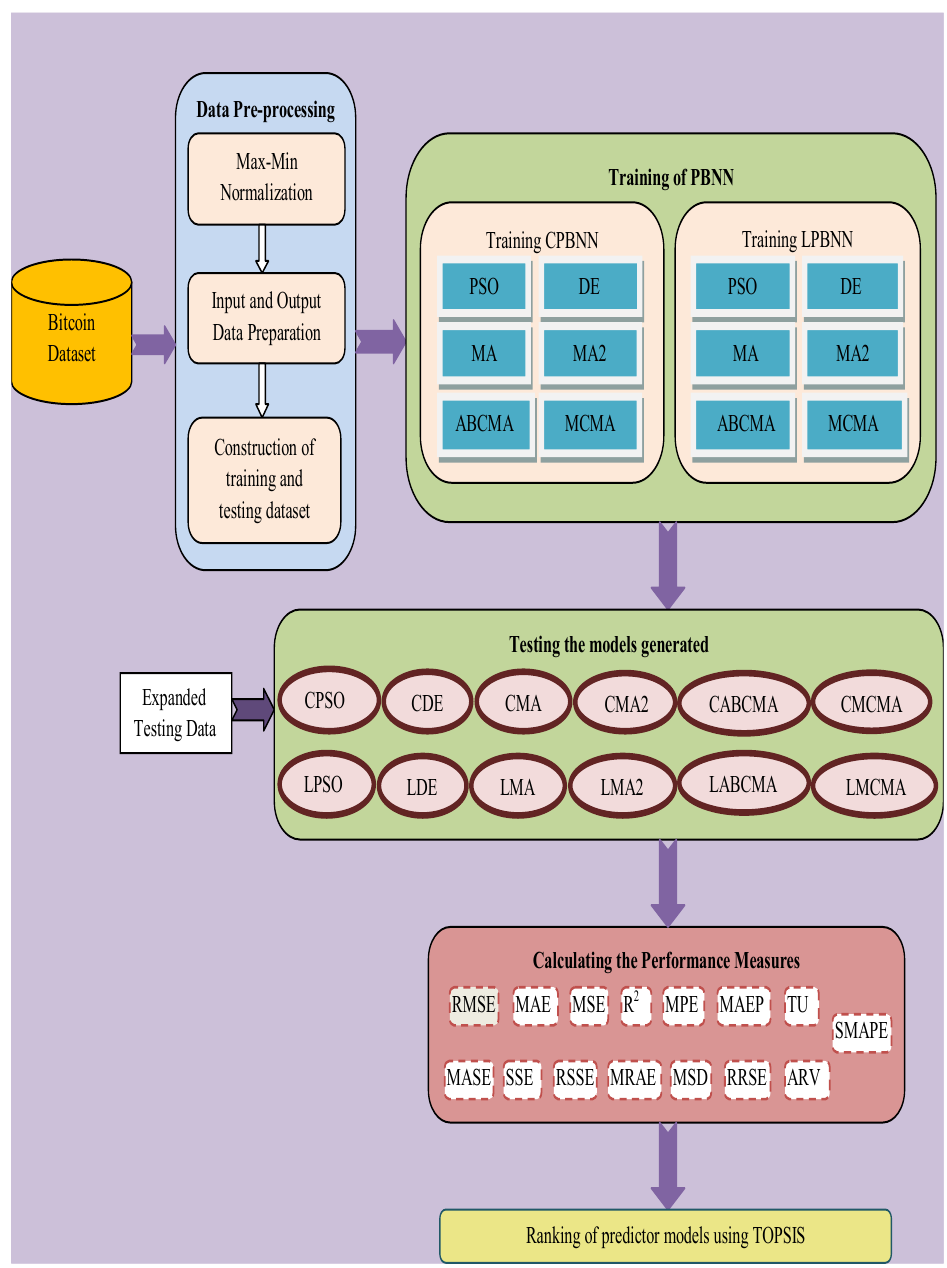
Figure 2. Proposed Polynomial Based Neural Network Bitcoin price predictor trained using a new Mutated Climb Monkey Algorithm.